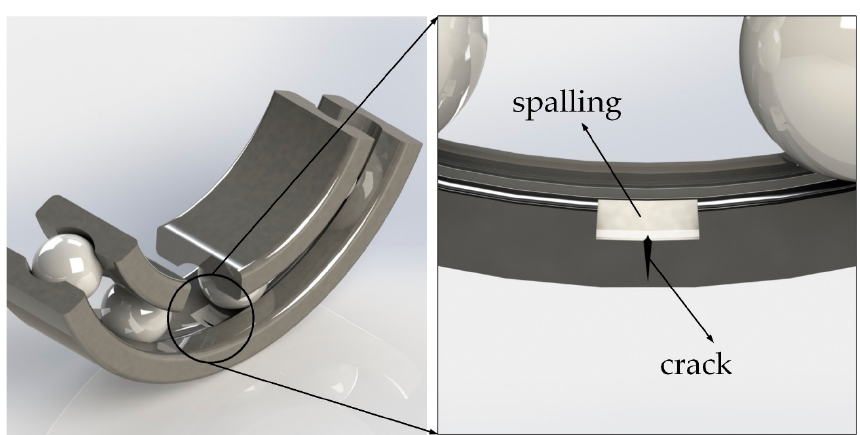
Figure 4. A schematic cross-sectional view of a crack at a spalling fault location in the ceramic bearing outer ring.